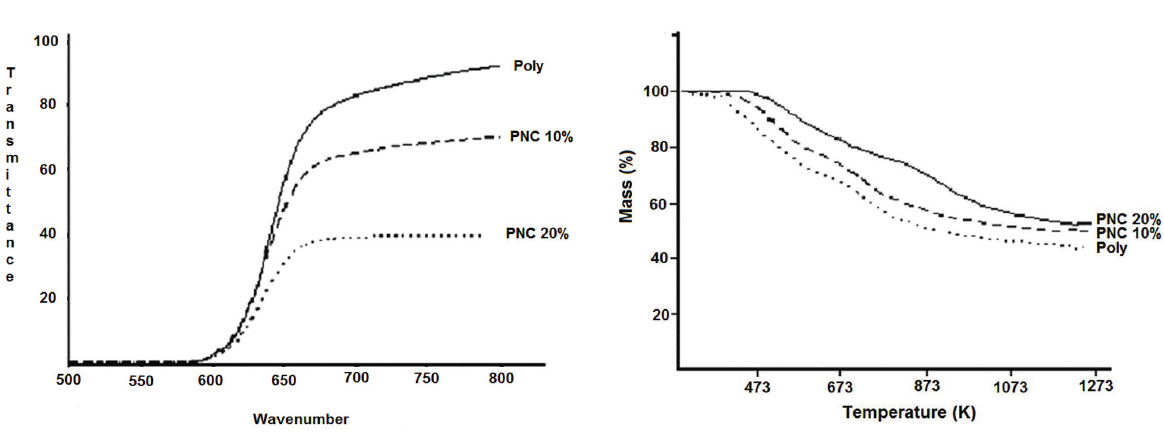
Figure 7. Uv-vis spectra in unit of cm (cid:3) 1 of PAI 5 , PAI- nanocomposite films 5a and 5b .